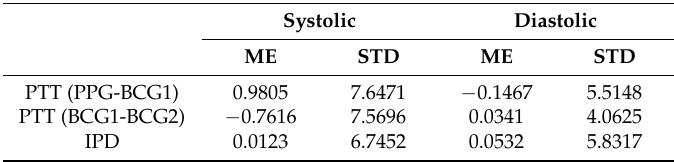
Table 1. Mean error (ME) and standard deviation (STD) values of systolic and diastolic blood pressures estimated via pulse transit time (PTT) and instantaneous phase difference (IPD).